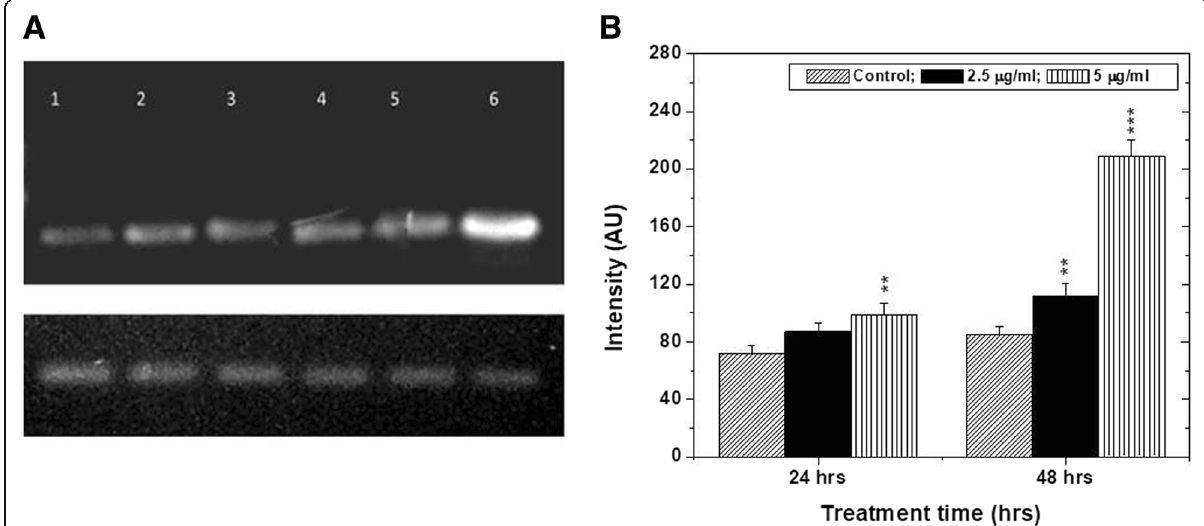
Fig. 12 A : Expression of N cadherin post treatment with AiP1: Lane 1 is Control (24 h); 2 is 2.5 μ g/ml AiP1 (24 h); 3 is 5 μ g/ml AiP1 (24 h); 4 is Control (48 h); 5 is 2.5 μ g/ml AiP1 (48 h); 6 is 5 μ g/ml AiP1 (48 h). B : Densitometric analysis of N-cadherin expression post treatment with AiP1. * p < 0.05; ** p < 0.01; *** p <